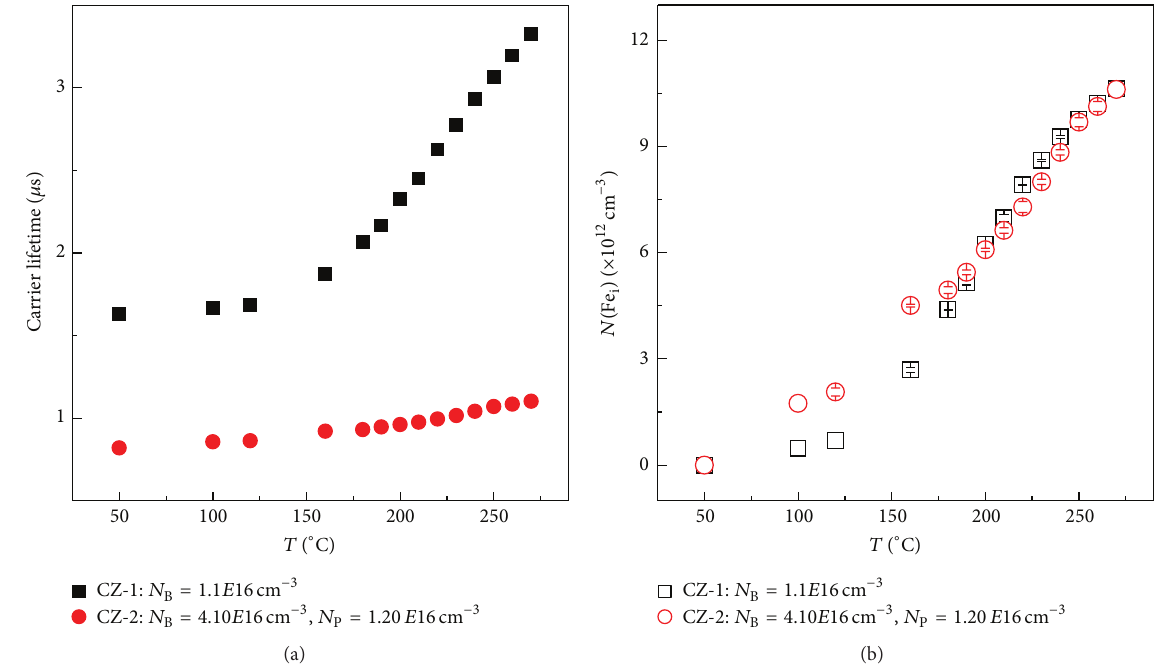
Figure 1: (a) The carrier lifetime as a function of temperature for CZ-1 and CZ-2. (b) The concentration of Fe i as a function of temperature for CZ-1 and CZ-2. Black squares and red circles refer to the CZ-1 and CZ-2 samples, respectively.